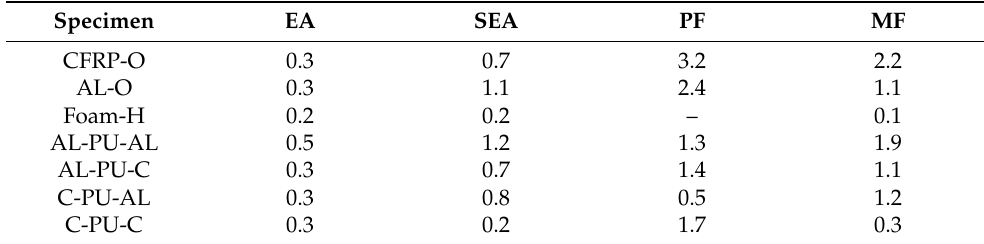
Table 5. Summary of standard deviations of single tubes and hybrid structures obtained from the experiment and simulation